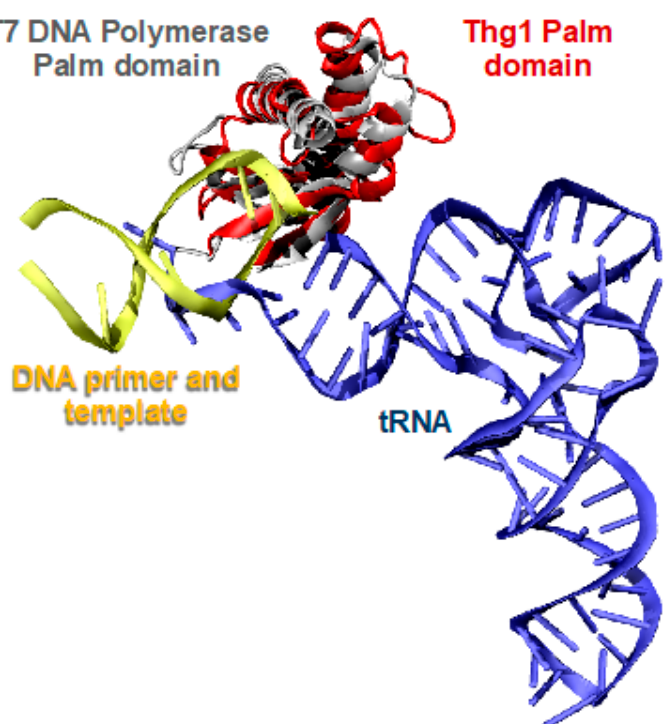
Figure 3. Forward and reverse polymerization is catalyzed by structurally similar enzymes but require opposing substrate orientation. The tRNA substrate (blue) of Thg1 (red) is in an opposing orientation compared to the DNA substrate and template (yellow) approaching the T7 DNA polymerase palm domain (grey).